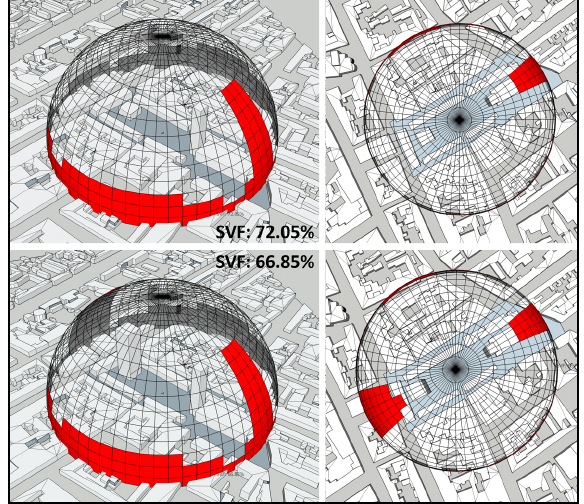
Figure 13. Sky View Factor (SVF) for existing and simulated tall buildings structure in city centre of Delft (cityGML – LOD1), by: author